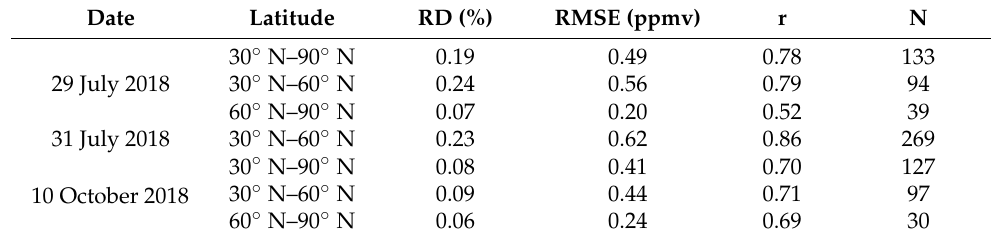
Table 2. Comparisons between Cross-track Infrared Sounder (CrIS) CO 2 profile and Civil Aircraft for the Regular Investigation of the atmosphere Based on an Instrument Container (CARIBIC) observation profile. Average of the relative difference (RD) CARIBIC-CrIS, root mean square error (RMSE), linear correlation coefficient (r) and the number of collocated 0.5 ◦ grid cells (N).